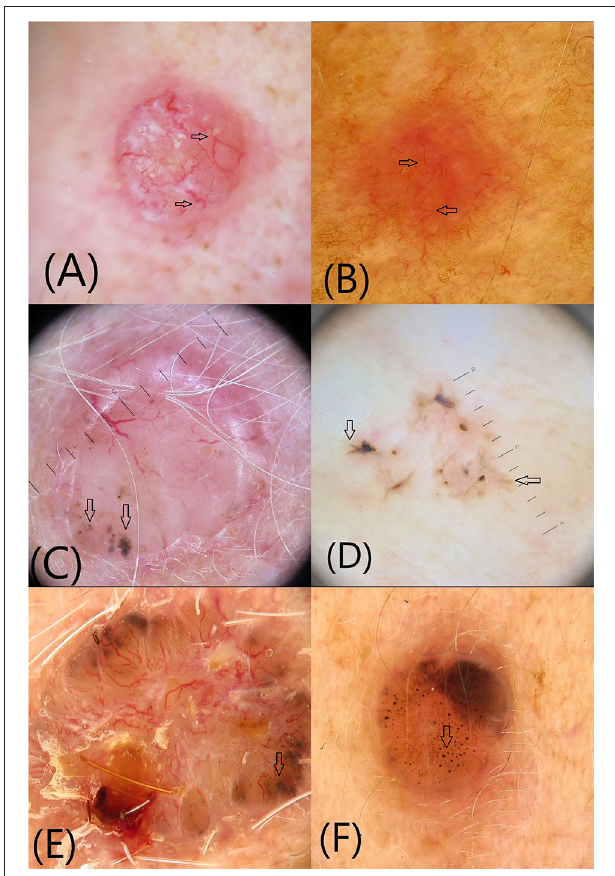
FIGURE 1 | Vascular and pigmented dermoscopic structures (arrows): (A) Arborising vessels; (B) Short fine telangiectasias (C) Blue-gray globules and dots (D) Maple leaf-like areas (E) Spoke-wheel structures (F) In-focus